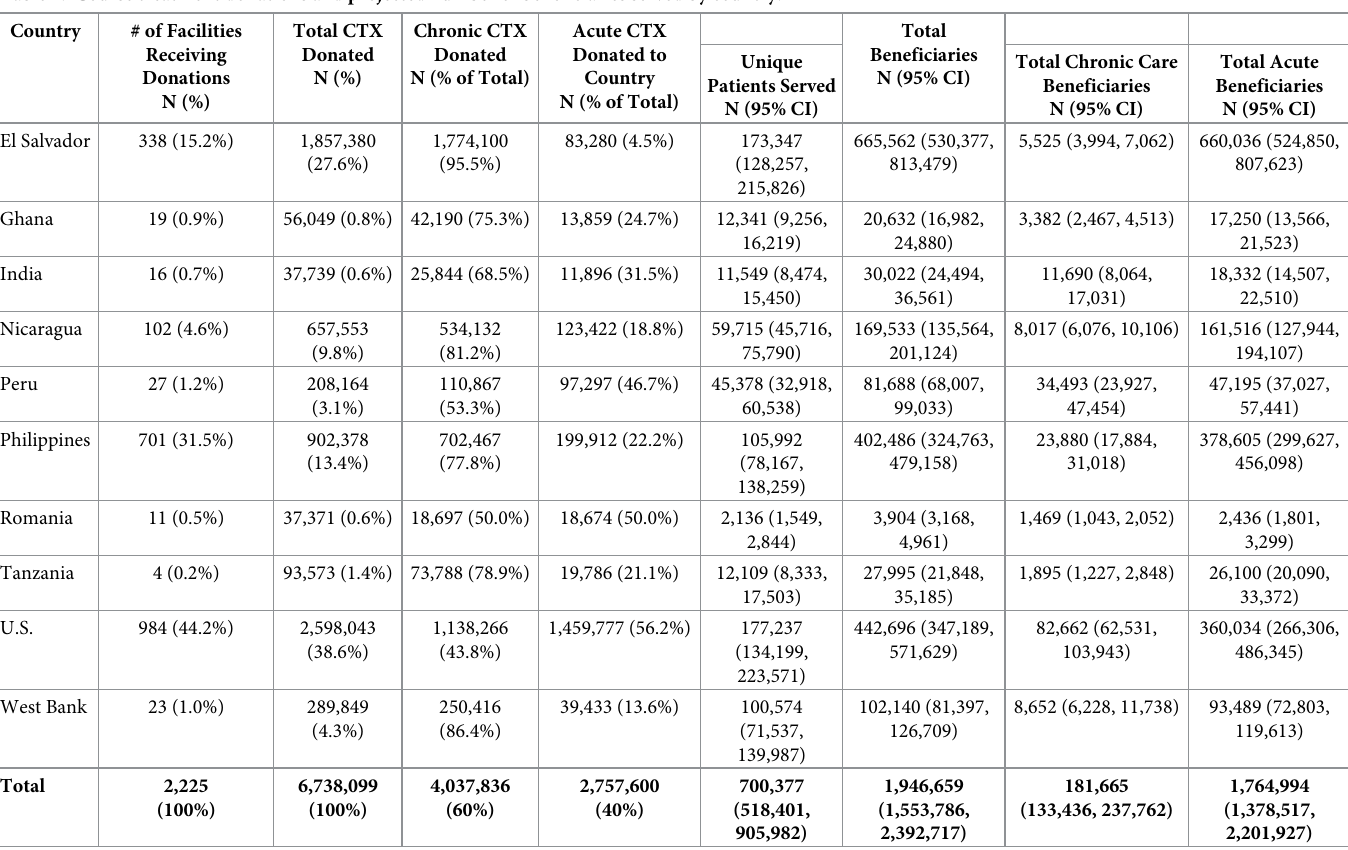
Table 2. Course treatment donations and projected number of beneficiaries served by